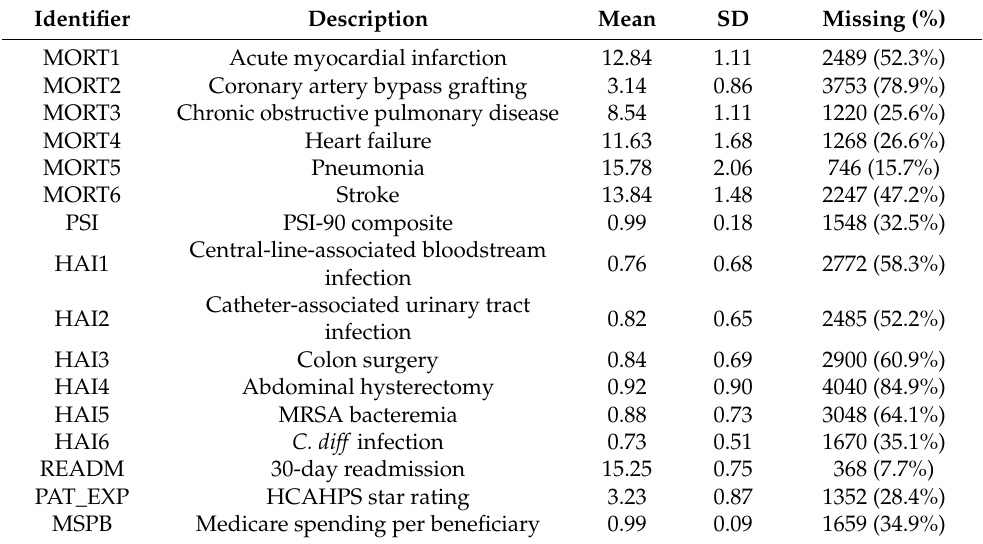
Table 1. Descriptive statistics across measures for n = 4758 facilities.